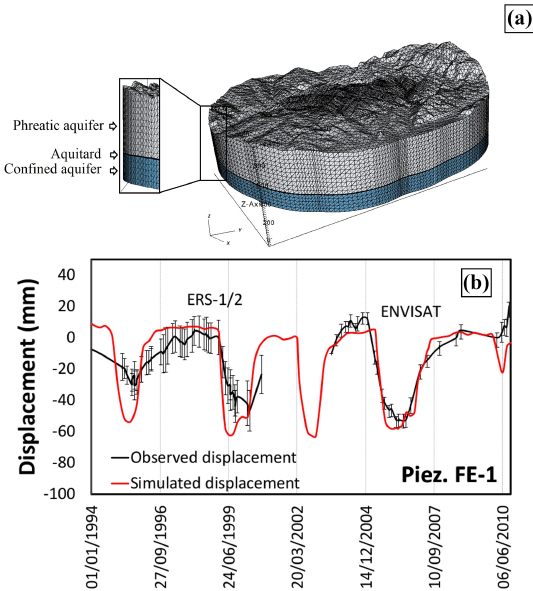
Figure 5. 3-D model of the Manzanares-Jarama wellfield (a) and simulated and observed displacement at piezometer FE-1. (b) See the location in Fig. 1. The observed displacements are an average value of the values measured on the PS located within a buffer zone of 1000m from the well, therefore also the standard deviation is